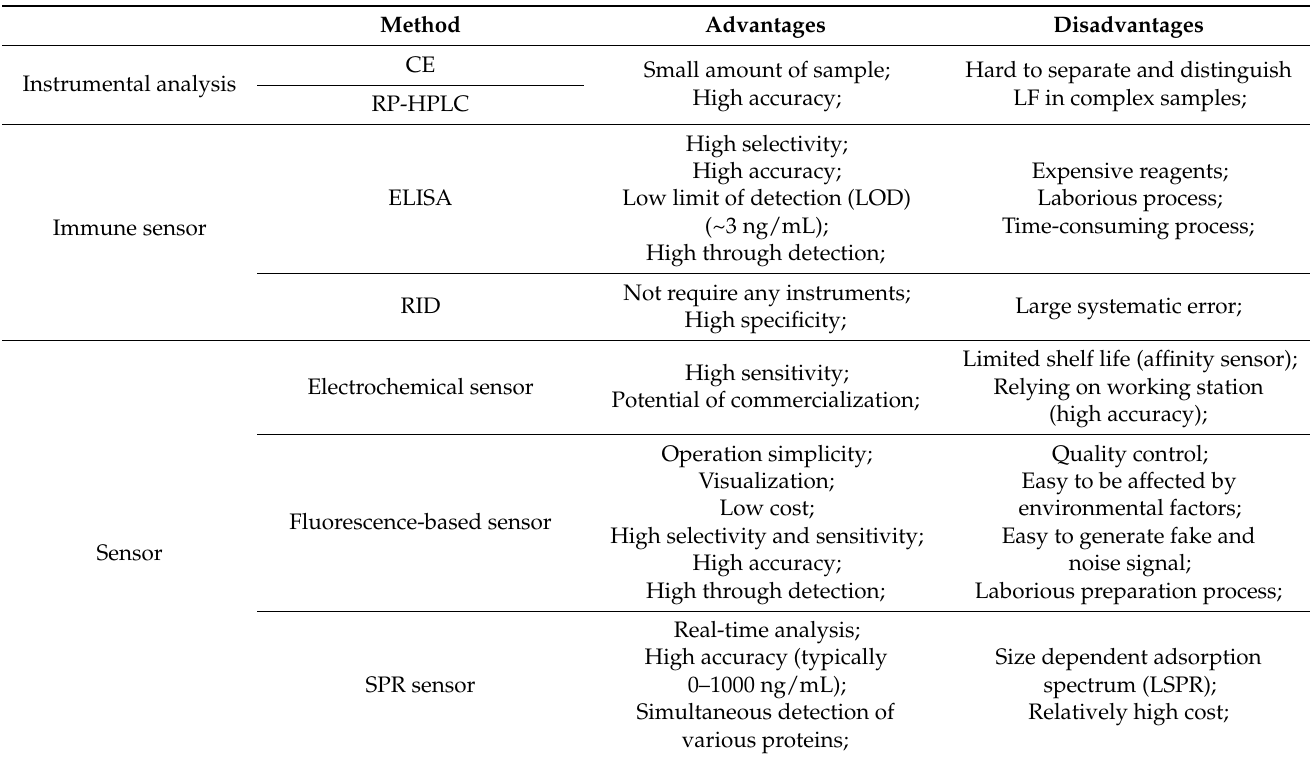
Table 1. Comparison of different methods for detecting